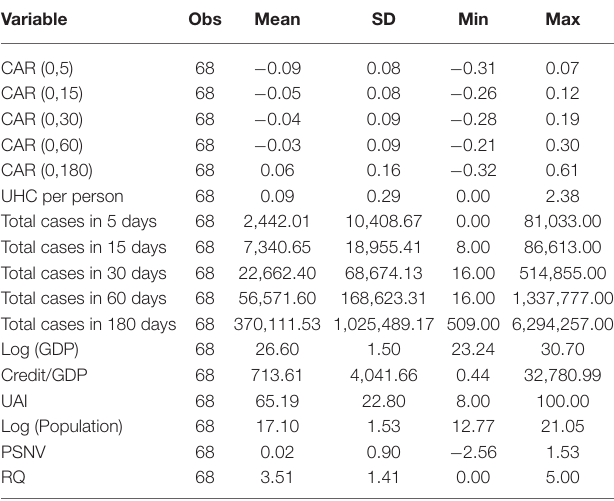
TABLE 3 | Descriptive statistics of main